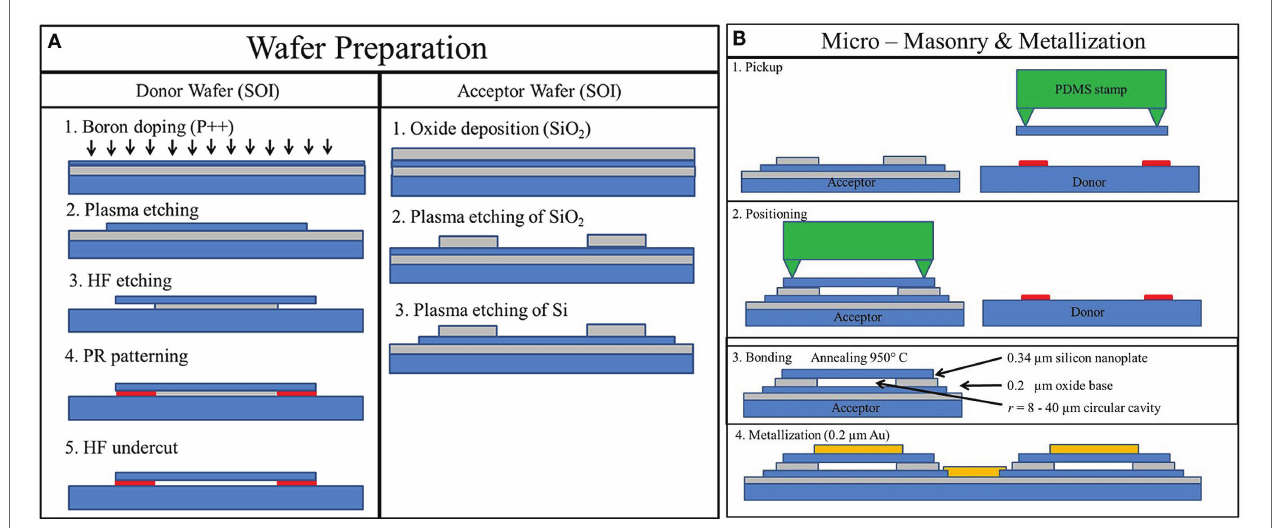
FigUre 2 | Fabrication process involving (a) the preparation of both donor and acceptor substrates and (B) the micro-masonry step used to transfer and bond nanoplates onto base structures followed by metallization to create interconnect lines .